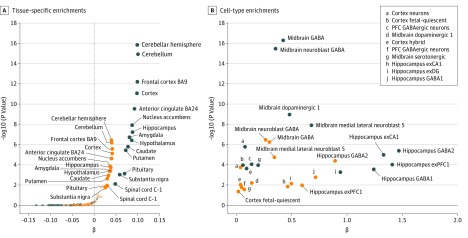
Enrichment Analyses for Educational Attainment and Income A, Tissue-specific enrichments (brain tissues are indicated with solid circles; nonbrain tissues are indicated with open circles). B, Cell-type enrichments that were at least nominally significant (P < .05) in both traits. BA9 indicates Brodmann area 9; BA24, Brodmann area 24; exCA1, excitatory neurons in hippocampal subfield CA1; exDG, excitatory neurons in dentate gyrus; exPFC1, excitatory neurons in prefrontal cortex 1; GABA, γ-aminobutyric acid; and PFC, prefrontal cortex.